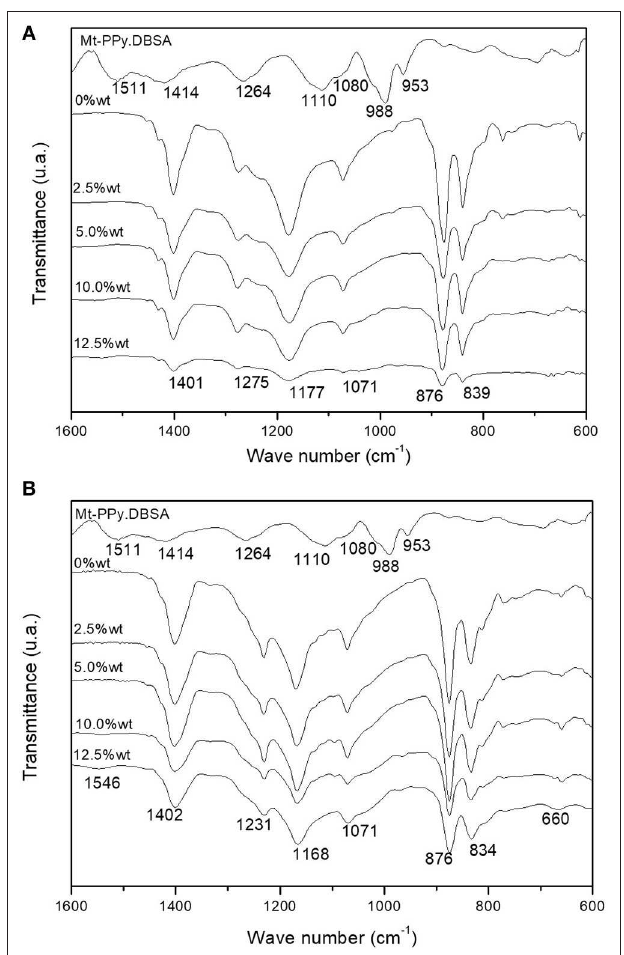
FIGURE 5 | FTIR spectra of PVDF and PVDF/Mt-PPy.DBSA (2.5, 5.0, 10.0, and 12.5 wt%) for (A) electrospun mats and (B) membranes by solution casting.